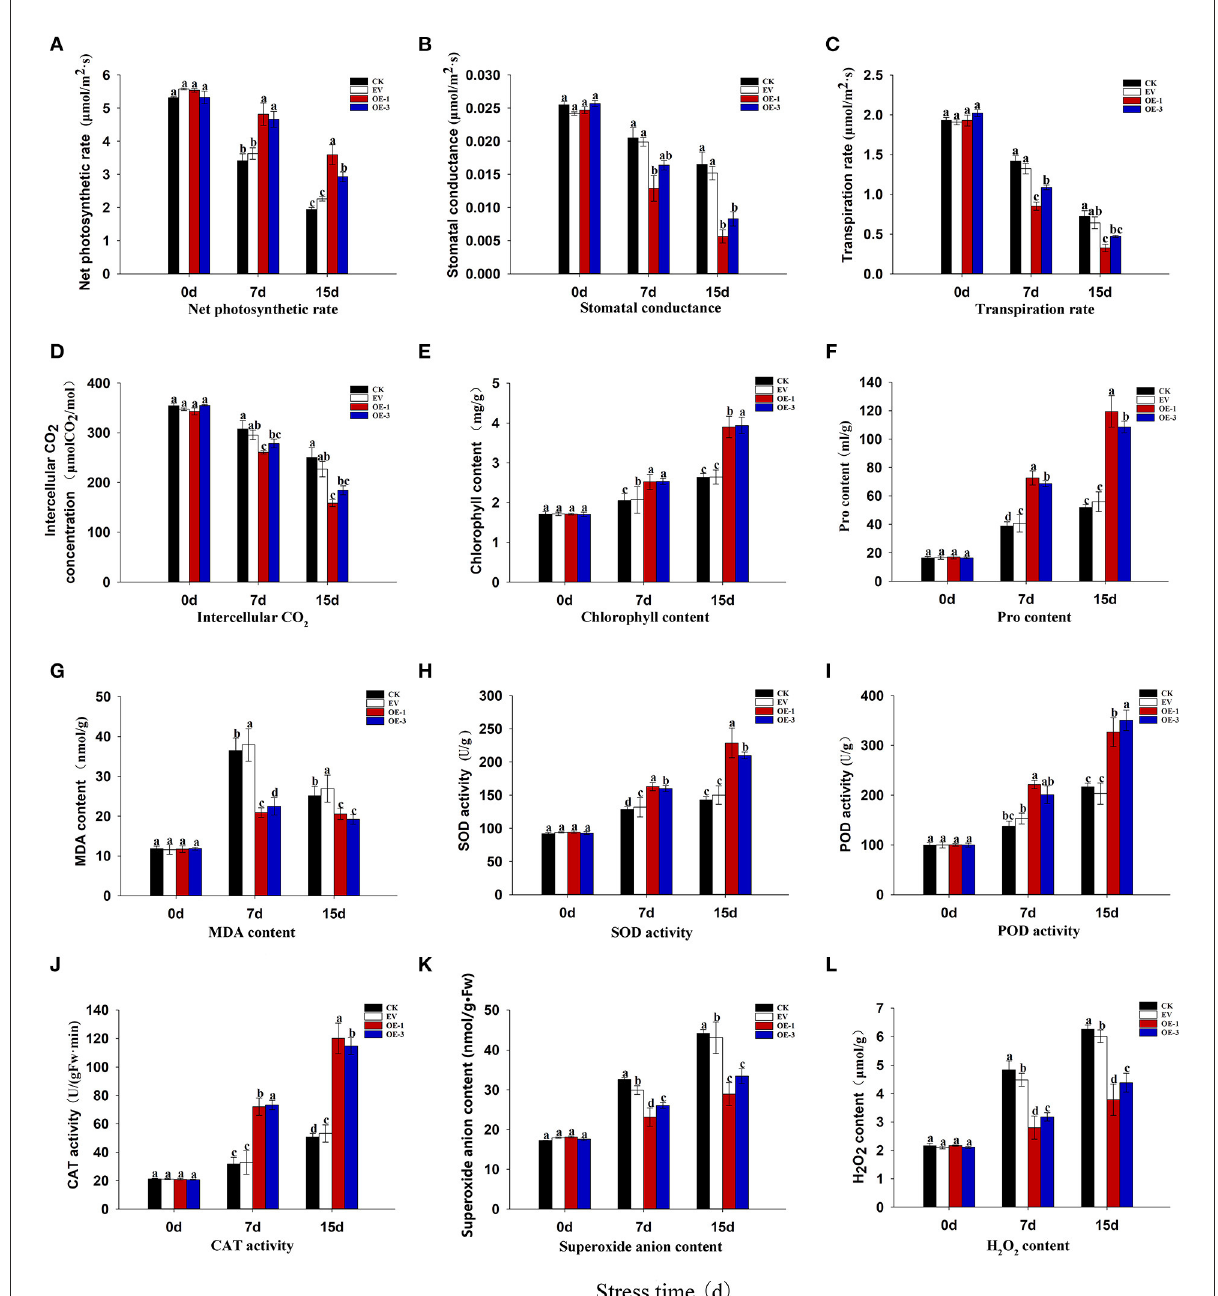
FIGURE5 Analysis of photosynthetic capacity in the transgenic tobacco lines overexpressing LpNAC17 under salt stress. (A) Net photosynthetic rate (Pn). (B) Stomatal conductance (Gs). (C) Transpiration rate (Tr). (D) Intercellular CO 2 concentration (Ci). (E) Chlorophyll (Chl) content. (F) Proline (Pro) content. (G) malondialdehyde (MDA) content. (H) Superoxide dismutase (SOD) activities. (I) Peroxidase (POD) activities. (J) catalase (CAT) activities. (K) Superoxide anion (O − 2 ) content. (L) Hydrogen peroxide (H 2 O 2 ) content. Bars represent the SE of three independent replicates and the different letters indicate the significant difference at the same time point ( P <